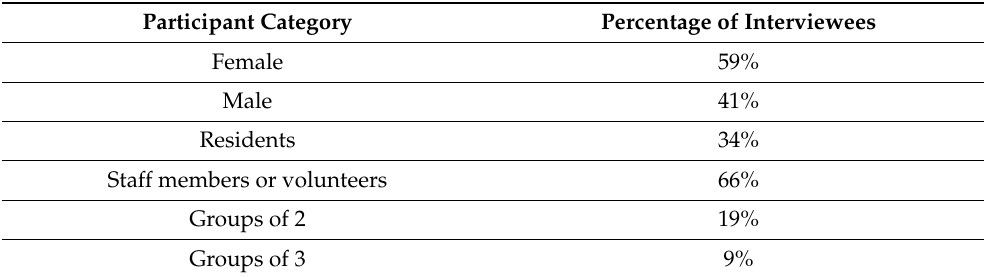
Table 2. Description of interviewees. Note that “Group of 2” refers to the percent of interviewees that interviewed in a group setting (i.e., two interviewees and one interviewer). Similarly, “Group of 3” indicates that three interviewees were